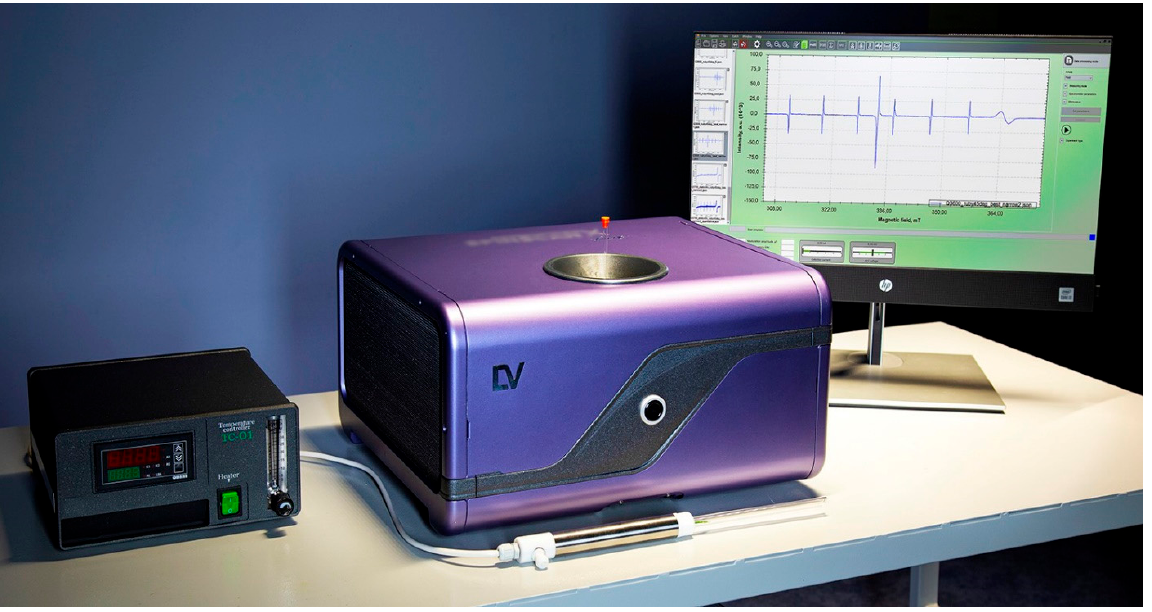
Figure 7. The appearance of a modern benchtop X-band EPR spectrometer (the 2022 model).